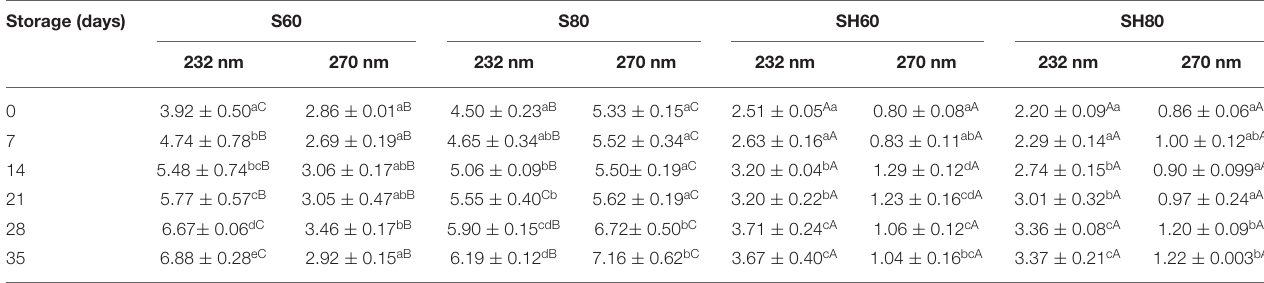
TABLE 3 | Oxidation spectrophotometric parameters k 232 and k 270 during storage at 20 ◦ C. Storage